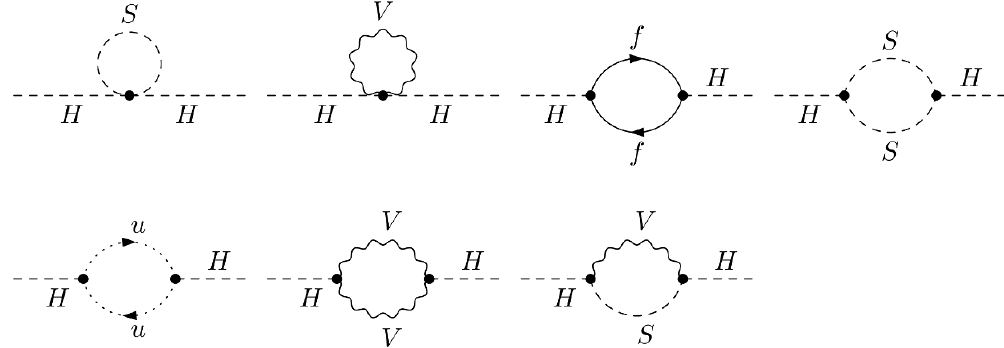
Figure 2 . Generic self-energy diagrams for the heavy, neutral CP-even Higgs self-energy, for other scalar self-energies the diagrams are analogous. Only massive particles